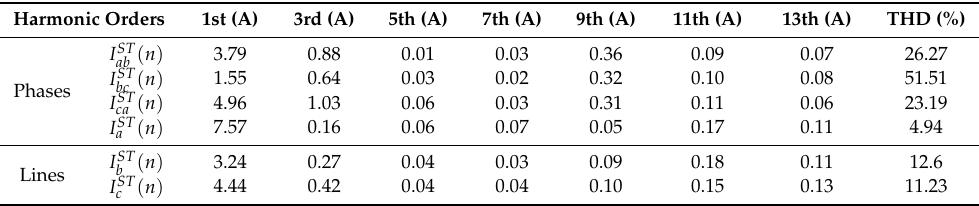
Table 2. Harmonics analysis of the STATCOM phases and synthesized lines